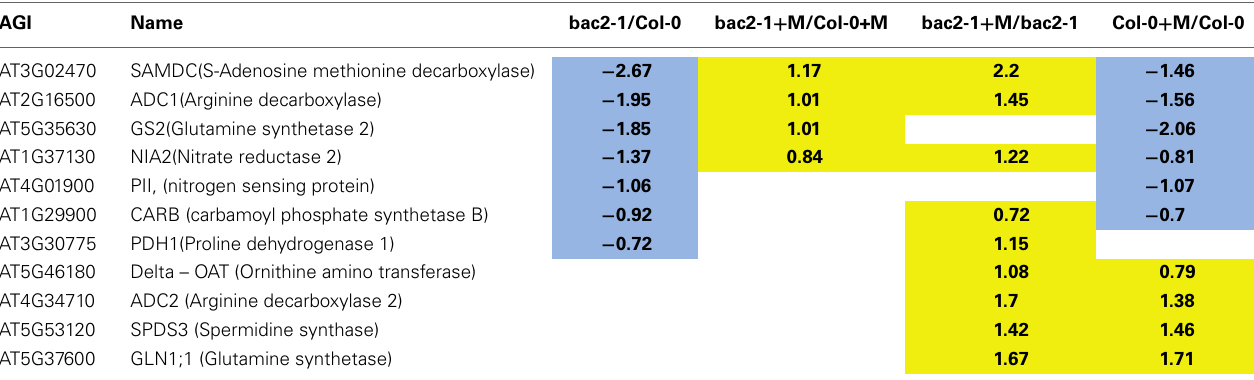
Table 2 | Amino acids and arginine metabolism related genes differentially expressed in bac2-1 .